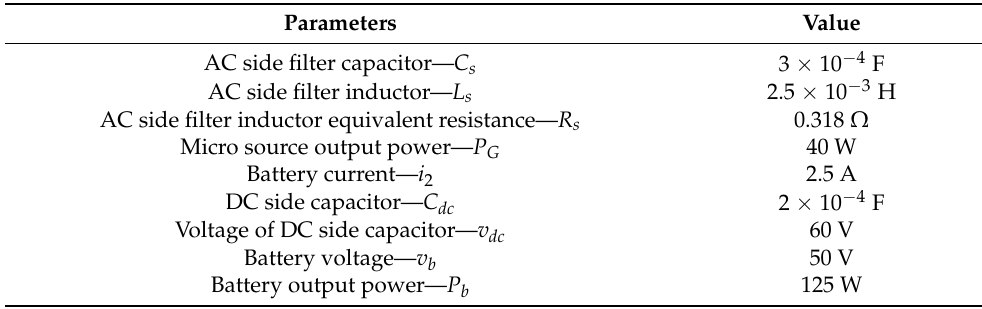
Table 3. Parameters of the AC microgrid prototype.